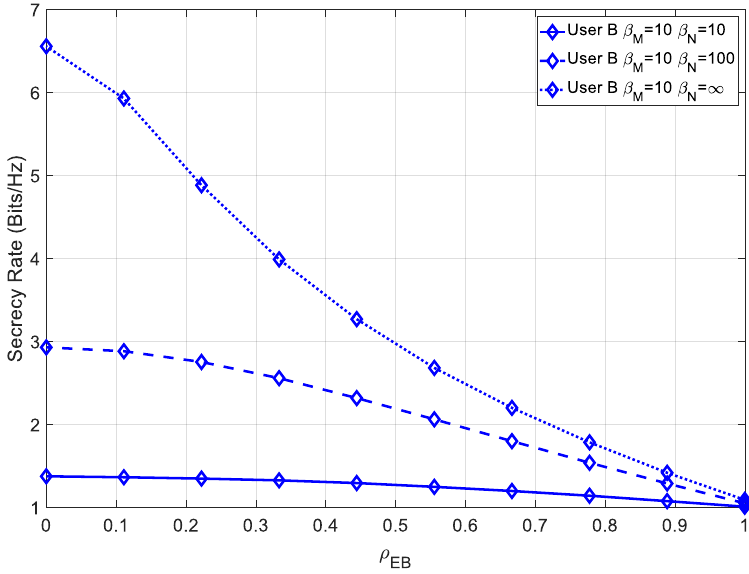
Figure 7. Secrecy rate of the 8 × 8 receiver B with different channel estimation errors and a permanent channel mismatch